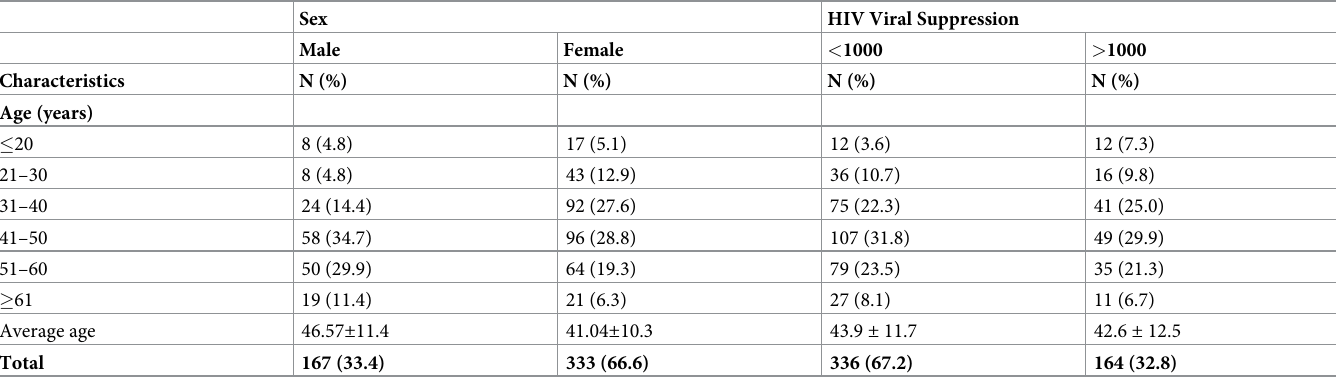
Table 3. Gender and viral suppression according to age difference.